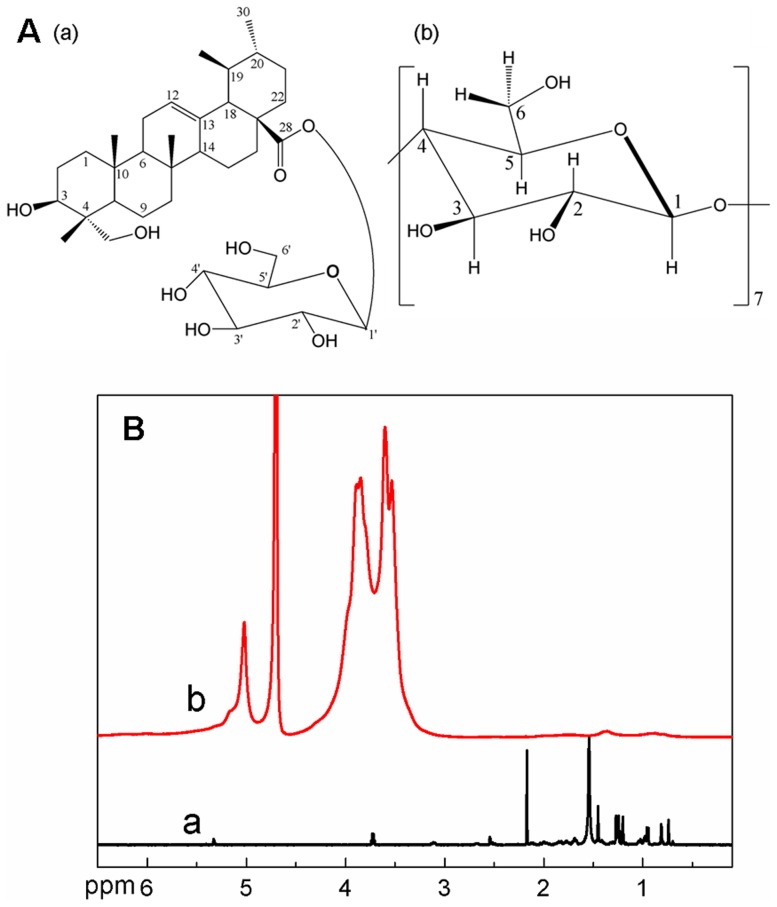
A Chemical structure of (a) PE and (b) the CD unit in CDP. B
1H NMR spectra of (a) PE and (b) PE-CDP.